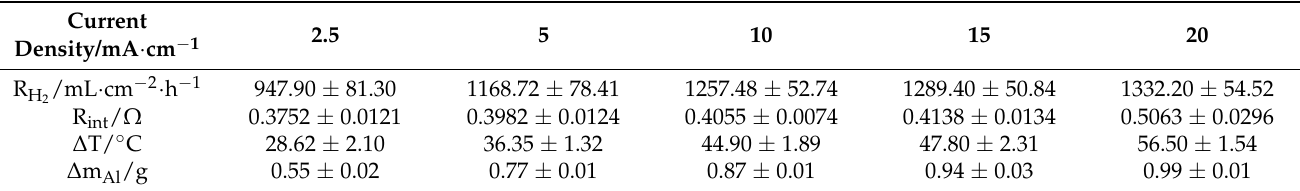
Table 3. The hydrogen-evolution rate (R H ), internal resistance (R int ), temperature change ( ∆ T), and 2 weight loss ( ∆ m) of aluminum anode at different discharge current